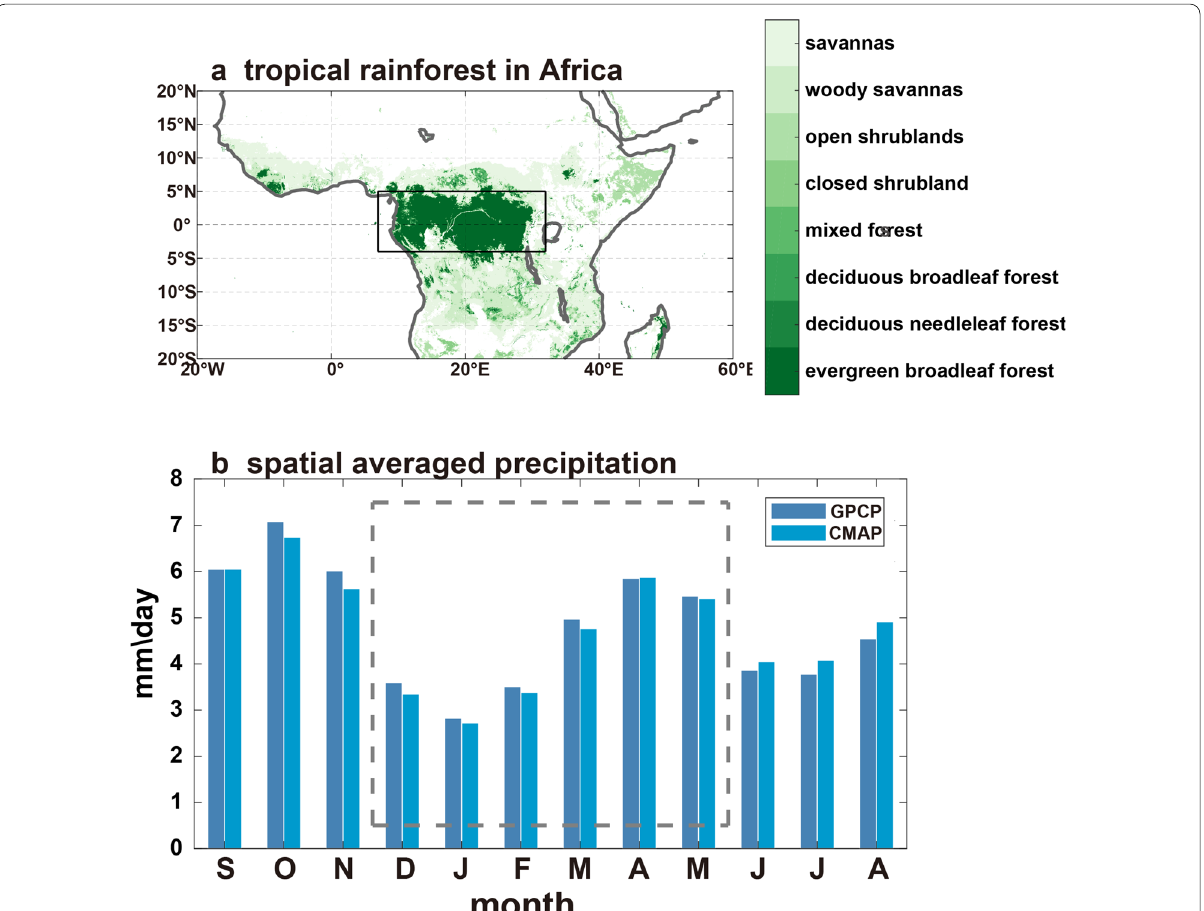
Fig. 1 African rainforests and monthly mean precipitation. a The distribution of tropical African rainforest, based on 2011–2015 MCD12C1 datasets. In this study, we focus on the domain (7°E‑32°E, 4°S‑5°N, the box), covering the most of African rainforest. b The spatial averaged (the box in a ) climatology of monthly precipitation, based on 1979–2015 GPCP and CMAP